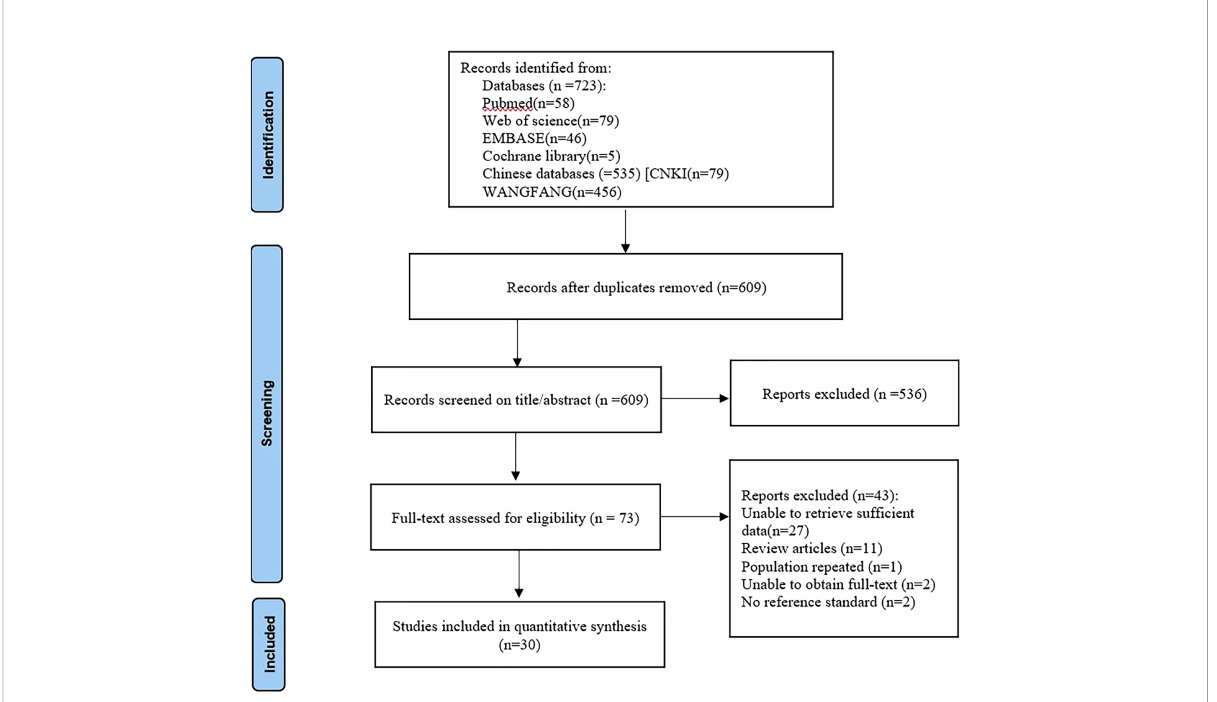
FIGURE 1 Flow diagram of study selection for meta-analysis according to PRISMA. PRISMA, Preferred Reported Items for Systematic Reviews and Meta